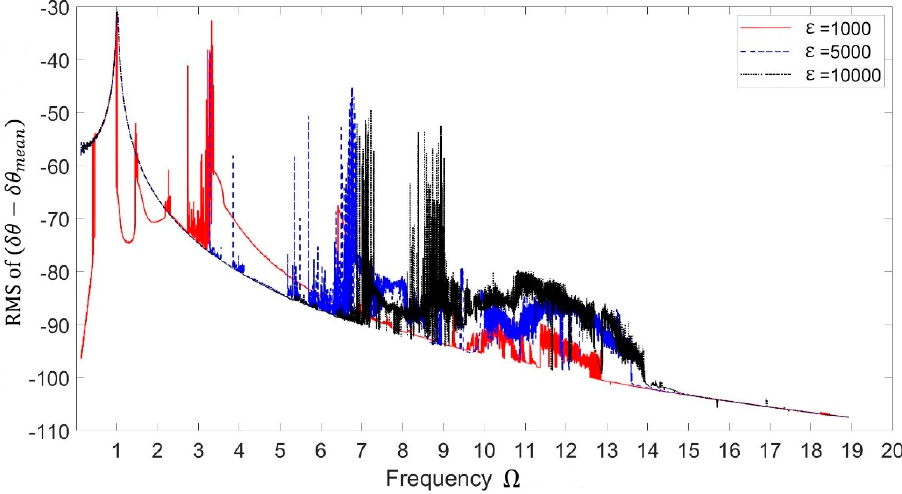
Figure 5. The frequency responses with different values of ε .